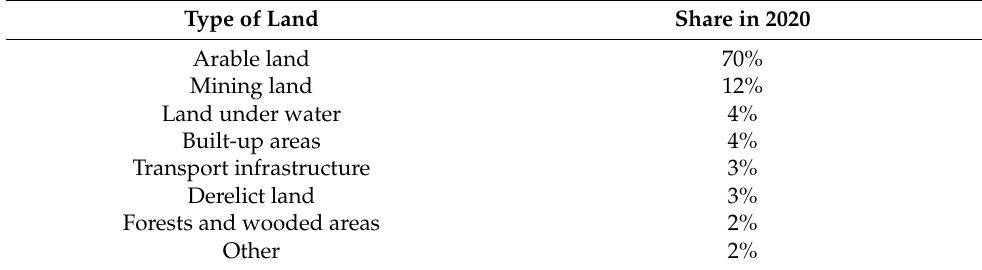
Table 9. Land use structure in the municipality of Kleczew. Type of